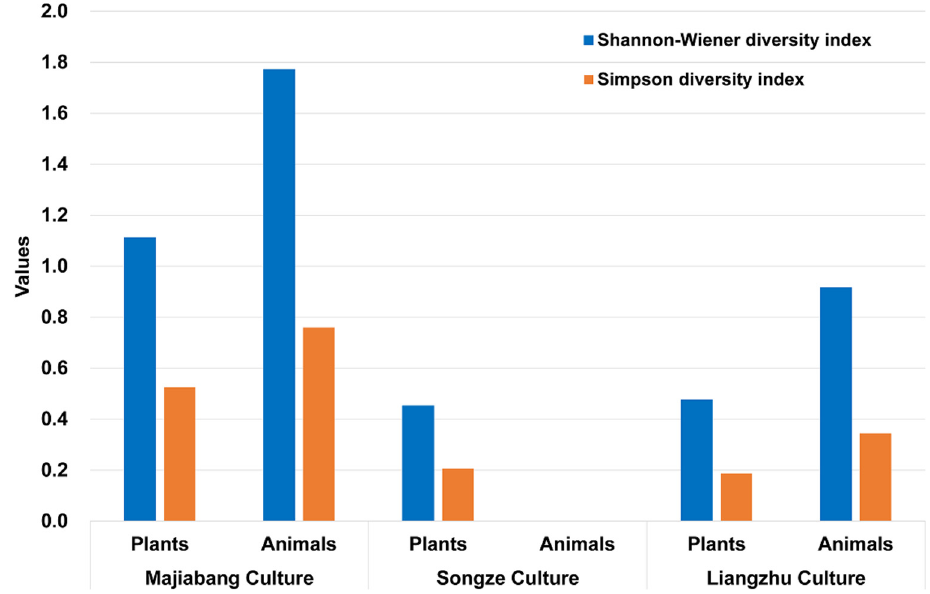
Figure 7. Bar chart of Shannon–Wiener and Simpson diversity values for Neolithic plant and animal foods for each period in the area around Taihu Lake.